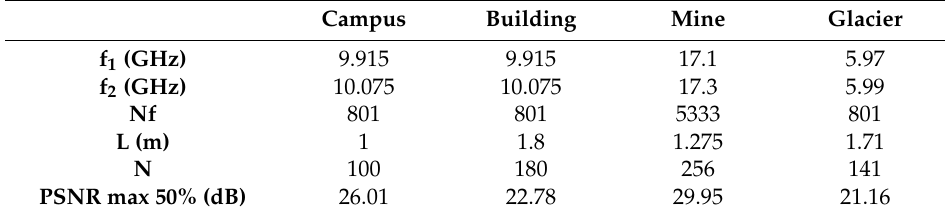
Table 5. Parameters of each measurement campaign and the highest value of PSNR obtained using 50% of